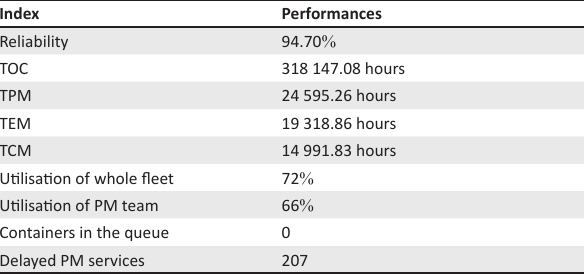
FIGURE 7: Reliability for applying only new straddles. TABLE 13: Outcomes for strategy